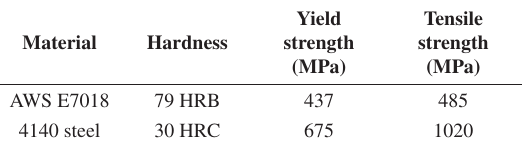
Table 2. Mechanical Properties of the AISI 4140 steel and AWS E7018 filler metal.